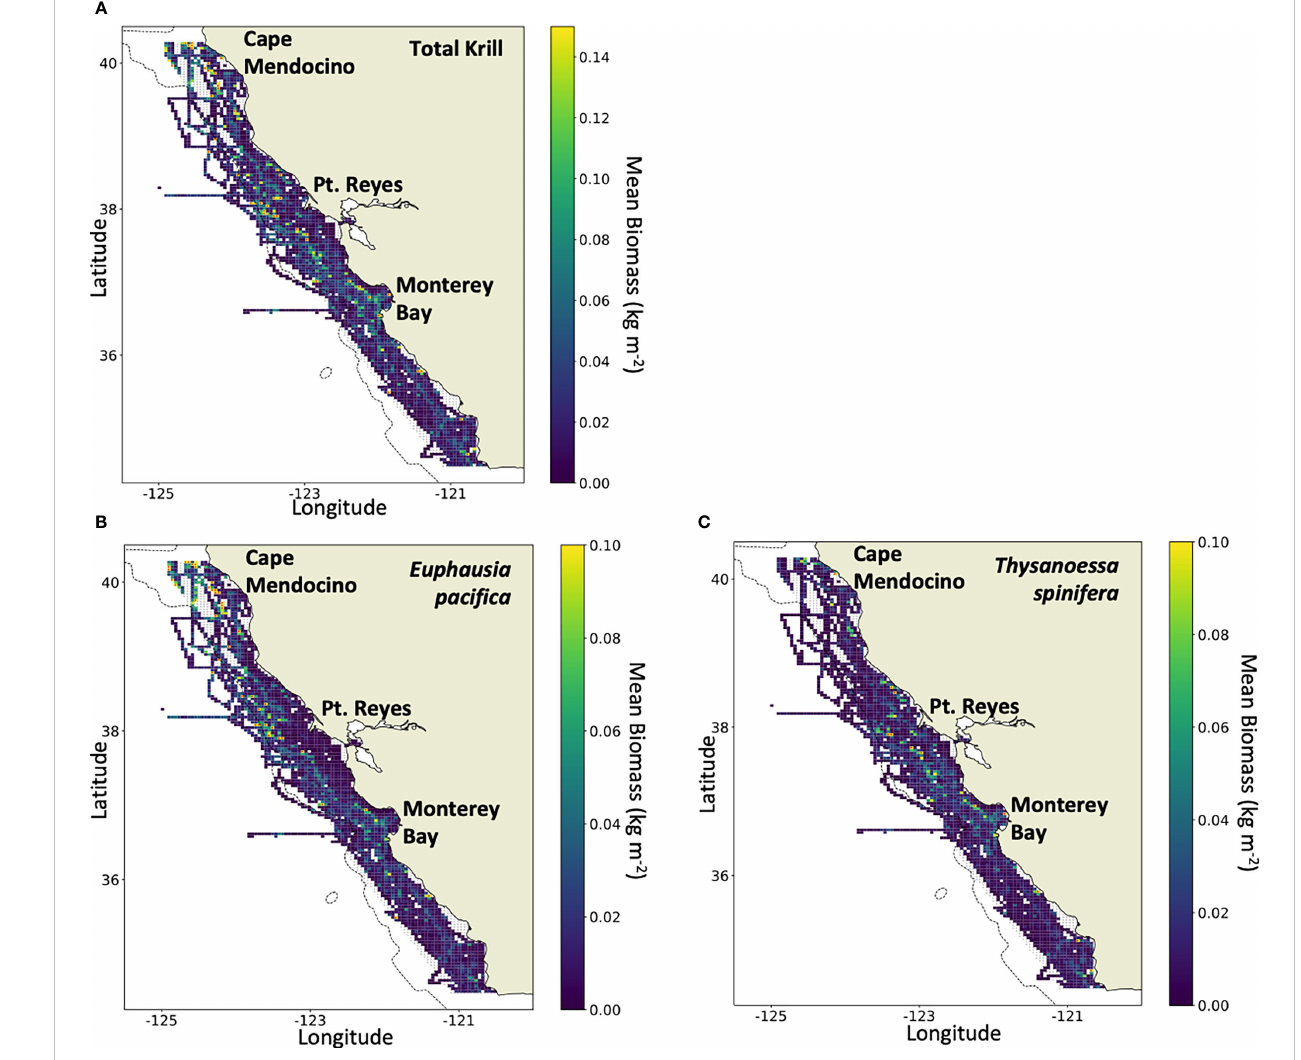
FIGURE 4 Mean biomass density (kg m -2 ) in the study area, 2012 – 2021, of (A) total krill, (B) Euphausia paci fi ca , and (C) Thysanoessa spinifera (note the varying difference in scales). Grid cells with a red marker exceed the maximum biomass set by the color scale. Maximum biomass density was (A) 0.60 kg m -2 of total krill, (B) 0.51 kg m -2 of E paci fi ca , and (C) and 0.22 kg m -2 of T. spinifera